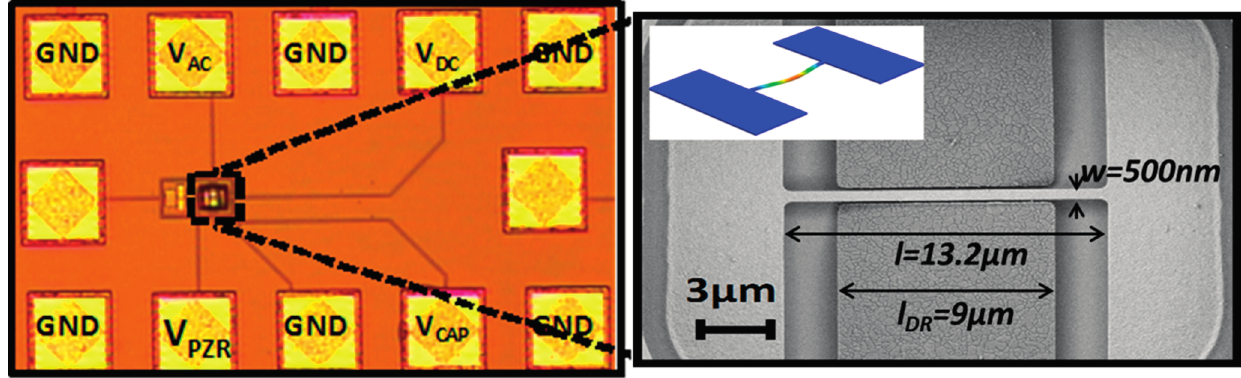
Figure 1. Left : Optical image of the integrated Polysilicon clamped-clamped beam in the CMOS technology; Right : Detail of the polysilicon resonator after its releasing in a SEM image. The thickness of the double clamped-beam is 282 nm and the gaps between driver electrodes and beam are 100 nm. The inset shows Coventor simulations for the first in plane resonant mode at f 0 = 25.5